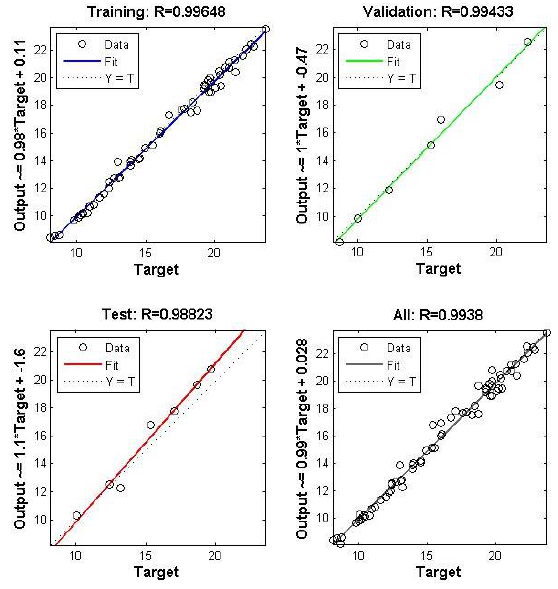
Figure 1. Time series of neural network training M c 3 run 1 NO 2 .